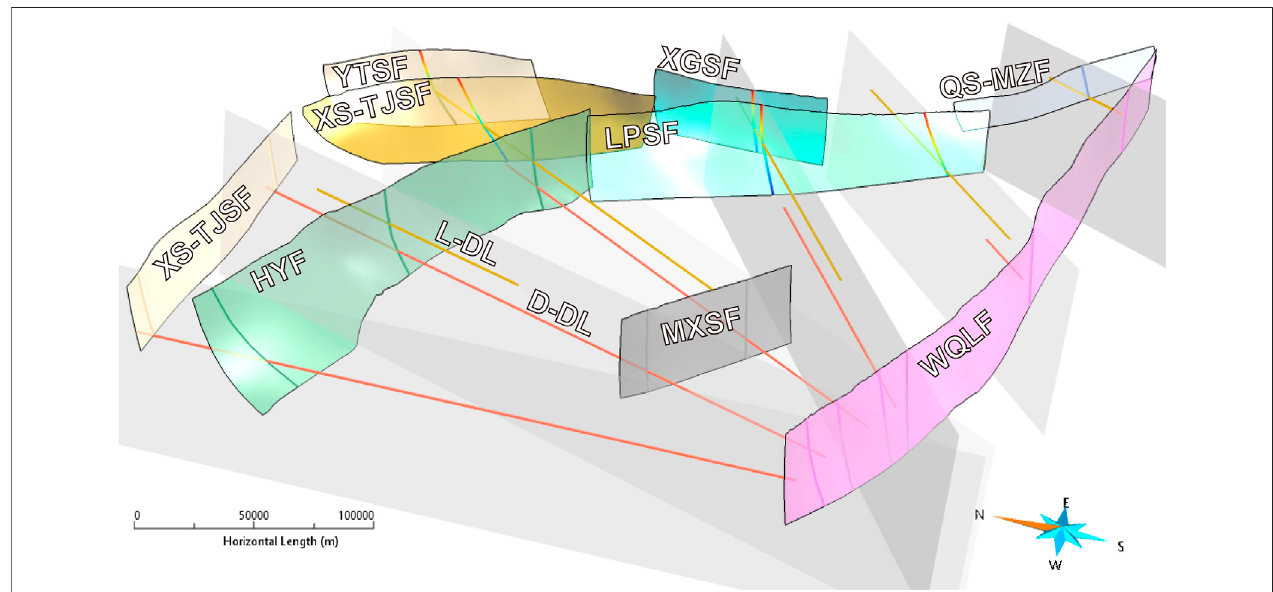
FIGURE 12 | Cut into slices of the V3 model. The fault planes are transparent displays and their contours are outlined by black lines.